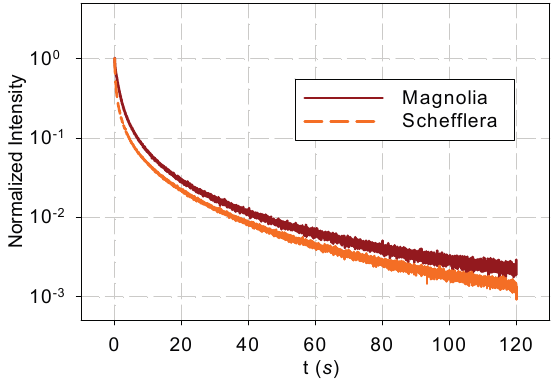
Figure 1. DF from magnolia and Schefflera leaves following the 0.5-s excitation light in the time domain.